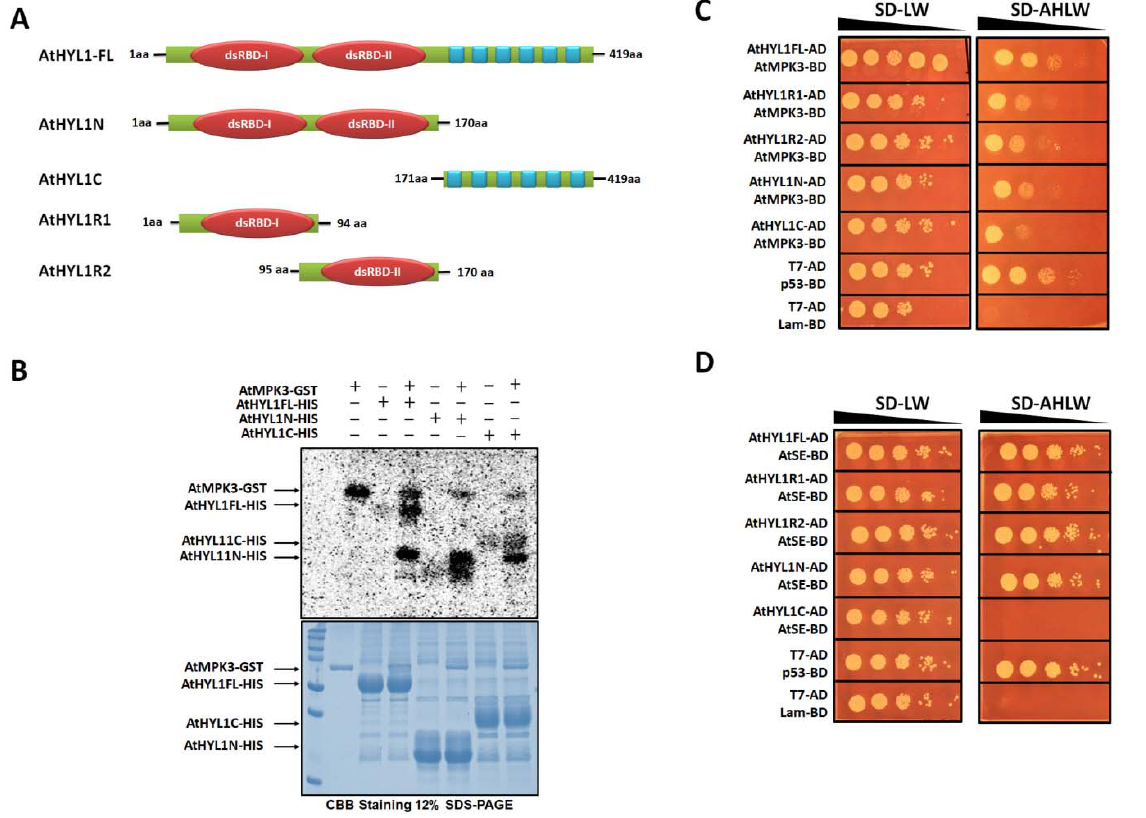
Figure 1. AtMPK3 phosphorylates at both terminals of AtHYL1. ( A ) A diagrammatic representation of AtHYL1 protein and its domain architecture. The N-terminal and C-terminal half used for protein expression, in vitro experiments, and Y2H are indicated by amino acid numbers. ( B ) An in vitro phosphorylation assay showing the phosphorylation of HYL1 full length (AtHYL1FL) and N-terminal (AtHYL1N) and C-terminal (AtHYL1C) regions by AtMPK3. The plus and minus signs represent the presence and absence of proteins. ( C , D ) A yeast two-hybrid assay showing the interaction of different versions of AtHYL1 (AtHYL1FL, AtHYL1N, AtHYL1C, AtHYL1R1—first dsRBD, and AtHYL1R2—second dsRBD) with AtMPK3 and AtSE, respectively. The images were taken after growing the yeast on respective medium at 28 °C for 3 days. All the experiments were performed three times to validate the results.